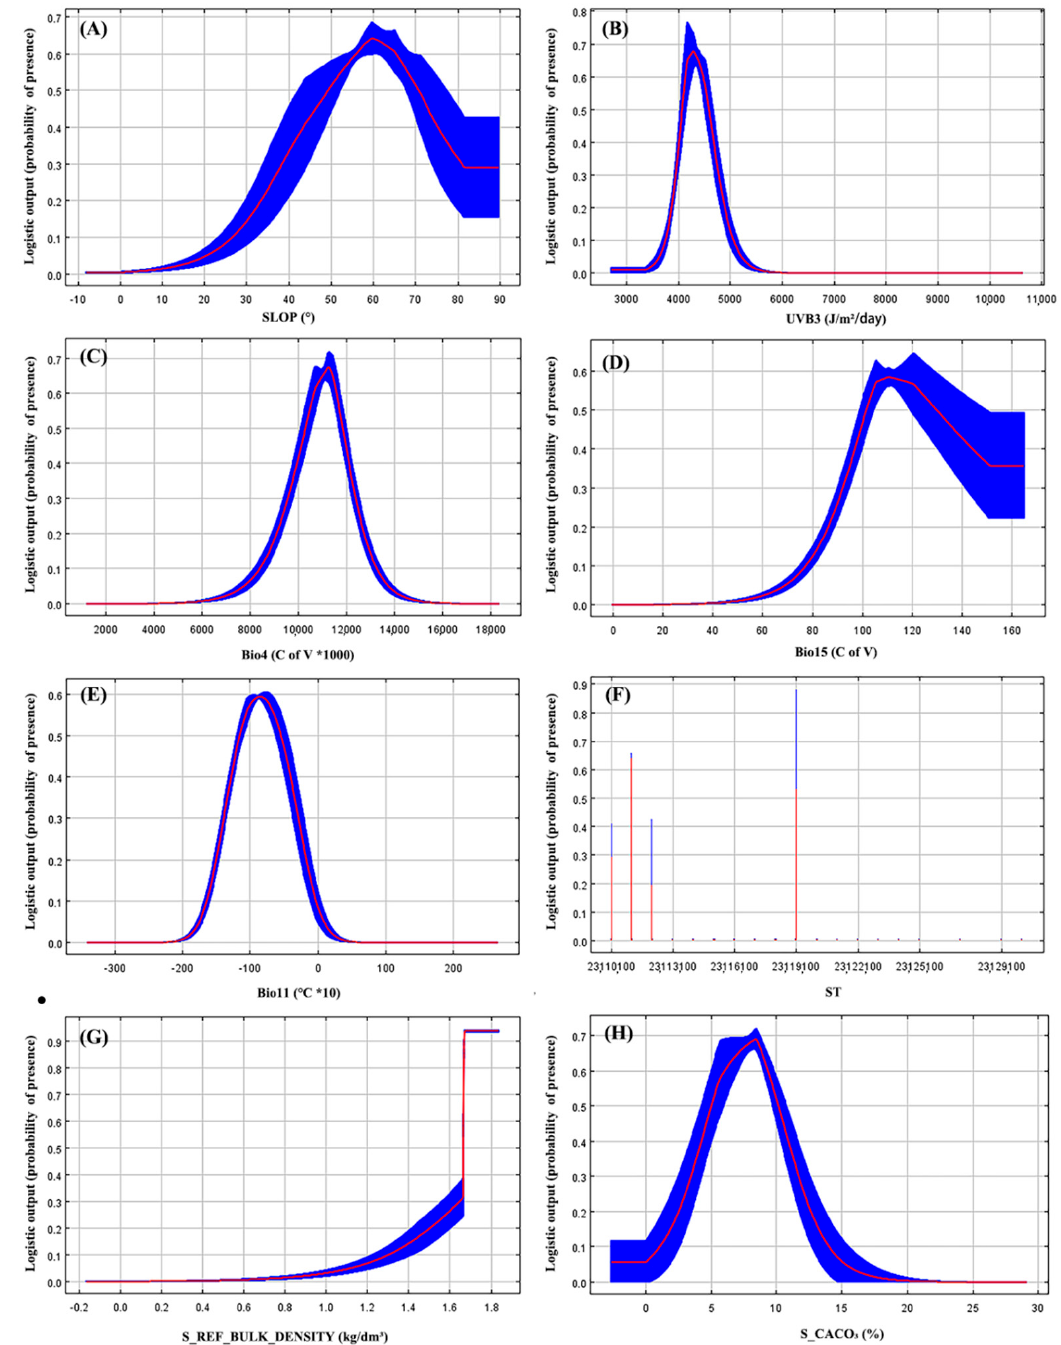
Figure 7. Response curves of the key environmental variables of the modeled distribution of Lonicera oblata based on the MaxEnt algorithm. ( A ) SLOP; ( B ) UVB3; ( C ) Bio4; ( D ) Bio15; ( E ) Bio11; ( F ) ST; ( G ) S_REF_BULK_DENSITY; ( H ) S_CACO 3